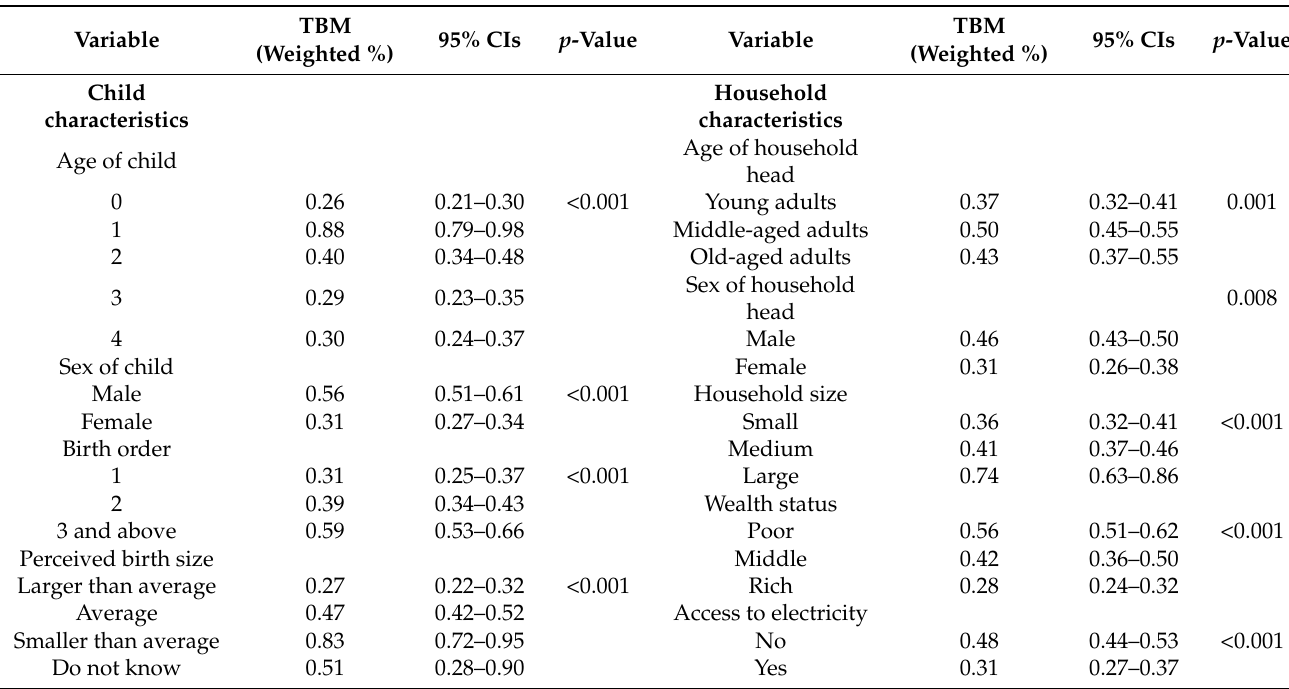
Figure 3. Maps showing the prevalence of triple burden of malnutrition in the four geographic regions in Sub-Saharan Africa. Source: constructed based on shapefiles from https://tapiquen-sig.jimdofree.com/descargas-gratuitas/mundo/ (1 December 2020) with permission from Carlos Efrain Porto Tapiquen, 2021. TBM: Triple burden of malnutrition. Table 2. Associations between child, mother, household and contextual factors and